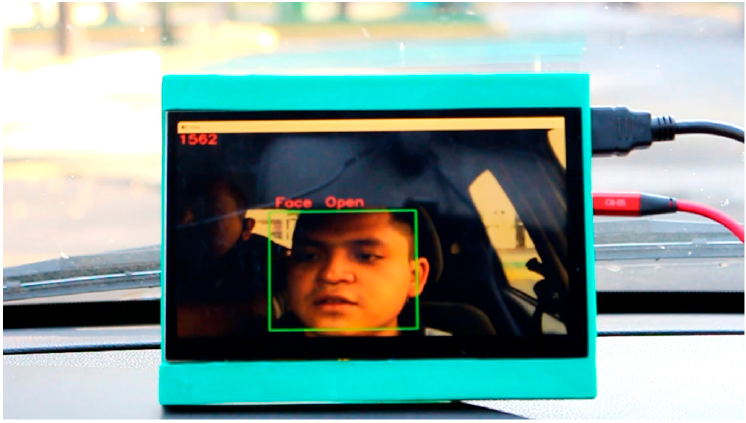
Figure 24. SOMN_IA. ( a ) The outward appearance of the SOMN_IA (black version); ( b ) the instal ‐ lation of the SOMN_IA (green version) inside of a vehicle.